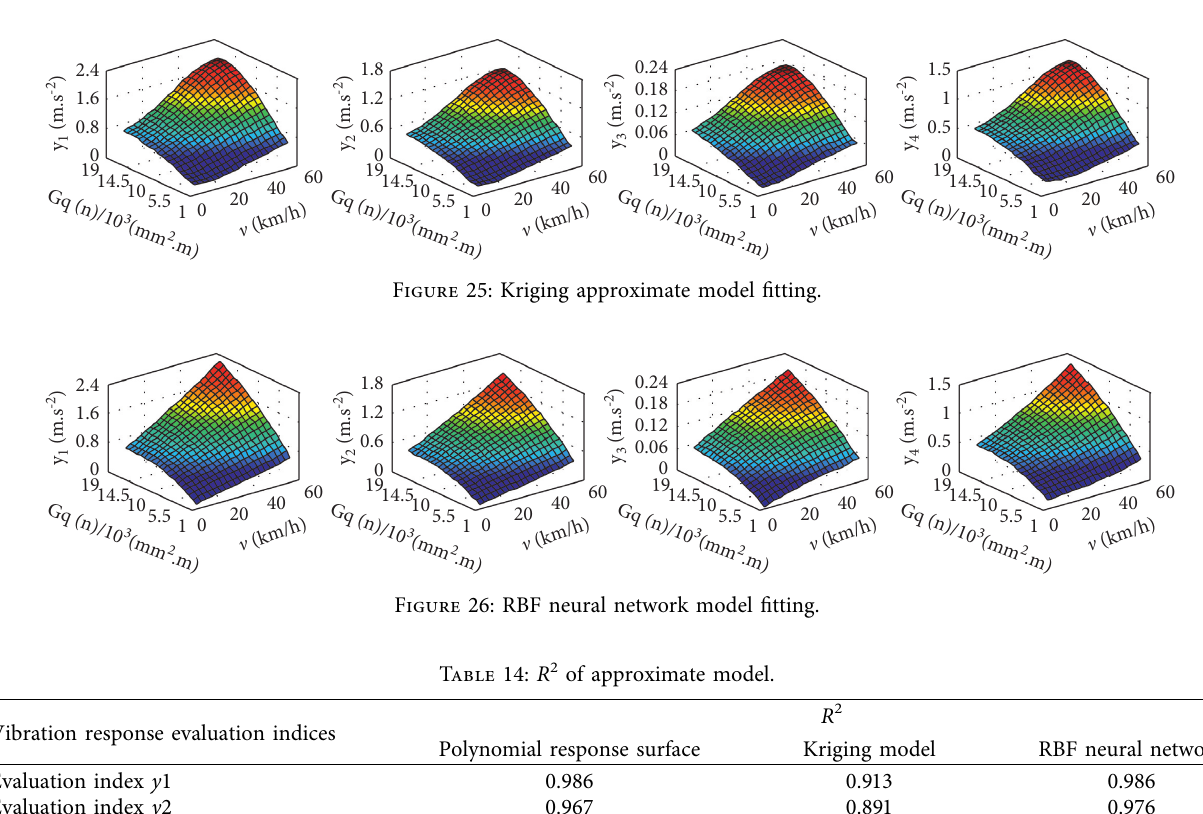
Figure 24: Model fitting of second-order polynomial response surface.